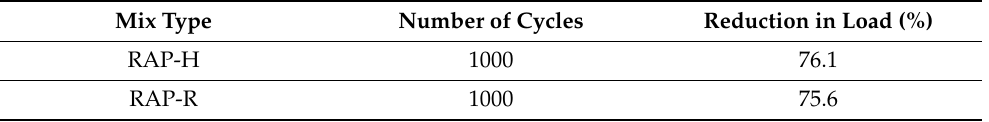
( b ) Figure 13. Dynamic modulus results at various test temperatures for mixes: ( a ) RAP-H, and ( b ) RAP- R.